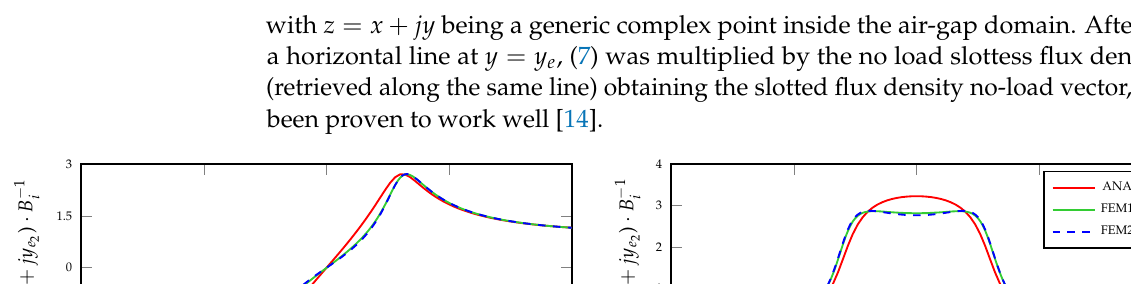
that is the flux density generated by an horizontal current sheet centered in the origin, with the slotted effect included according to the classical theory. In Figure 11a,b, the normal and tangential flux density distributions in p.u. produced by (8) with y e = y e with the FEM magneto-static simulation of case 1 are plotted.